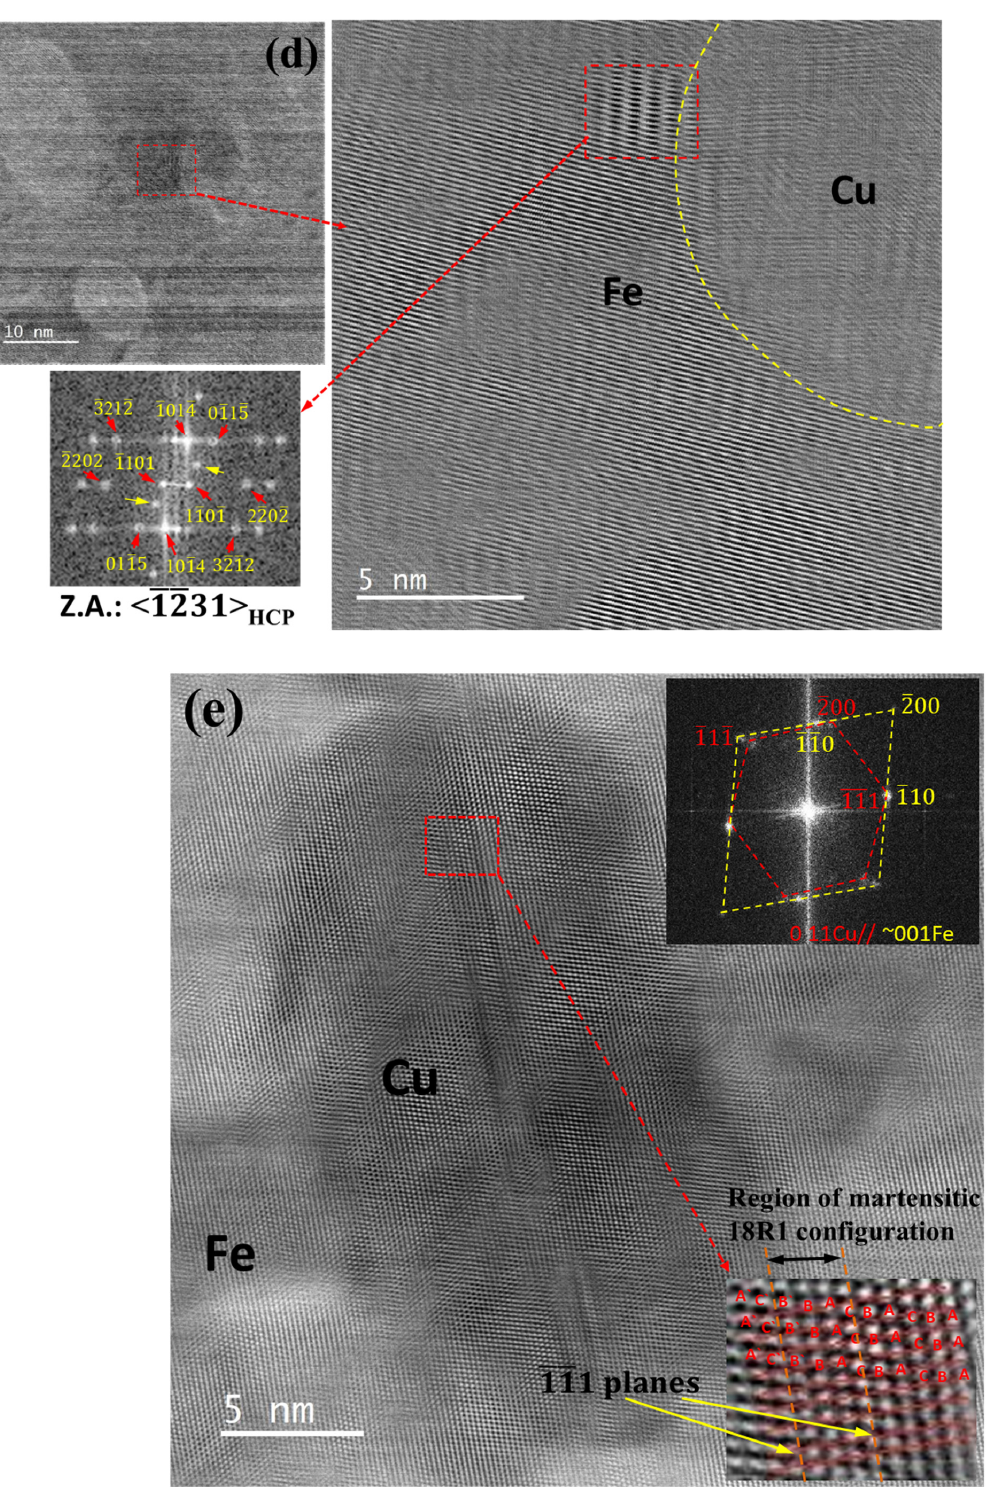
Figure 9. In post high-pressured (i.e., at 18.3 GPa) deformed samples: ( a ) Low magnification STEM-HAADF image showing presence of Cu and Fe precipitates in Fe and Cu grains, respec- tively. ( b ) Relatively higher magnification reveals fringe type characteristic (or modulated structure) in Cu precipitates. One kind of structural change observed in Cu precipitates exhibiting ( c ) changes in lattice structure from stable FCC to BCC at local regions, ( d ) formation of HCP lattice configuration and ( e ) presence of stacking faults within Cu